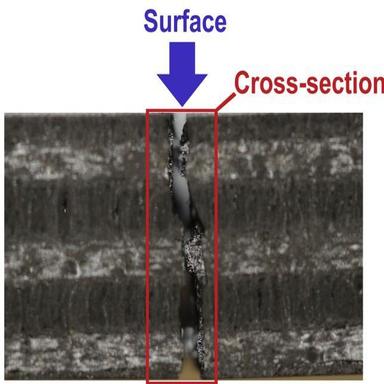
Locations analysed by SEM for the fracture arising from the tensile tests.